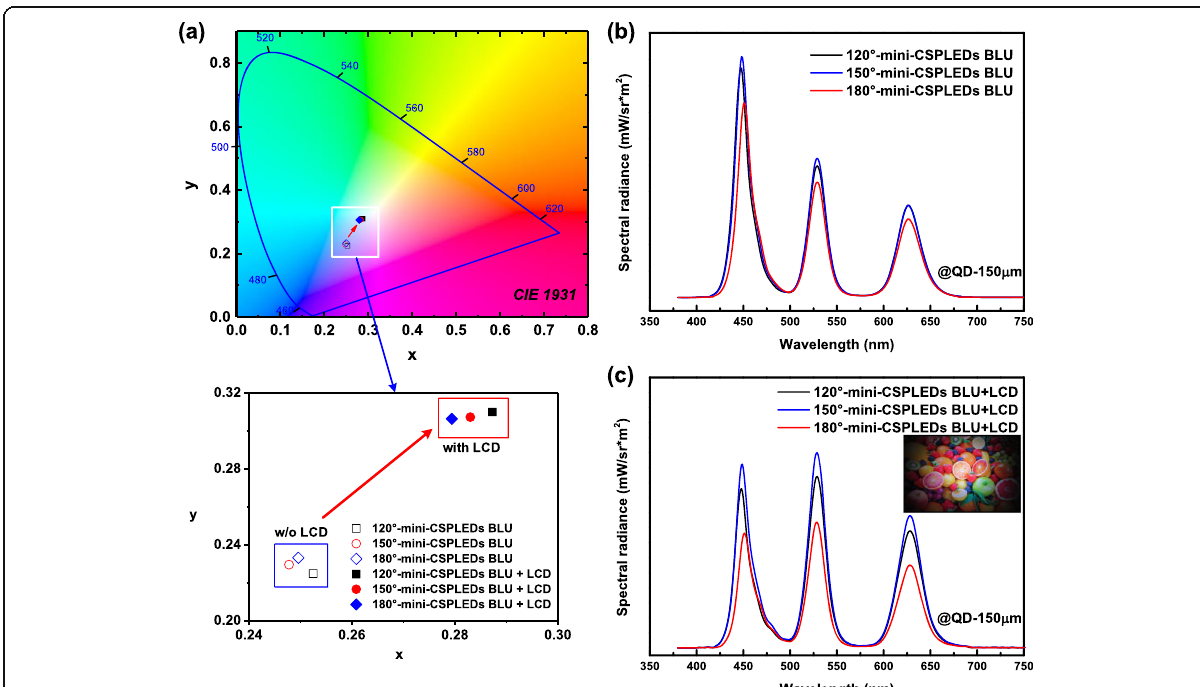
Fig. 8 a CIE chromaticity diagram. b , c EL spectra of three kinds of mini-CSPLED BLUs + 150 μ m-thick QD films with and without